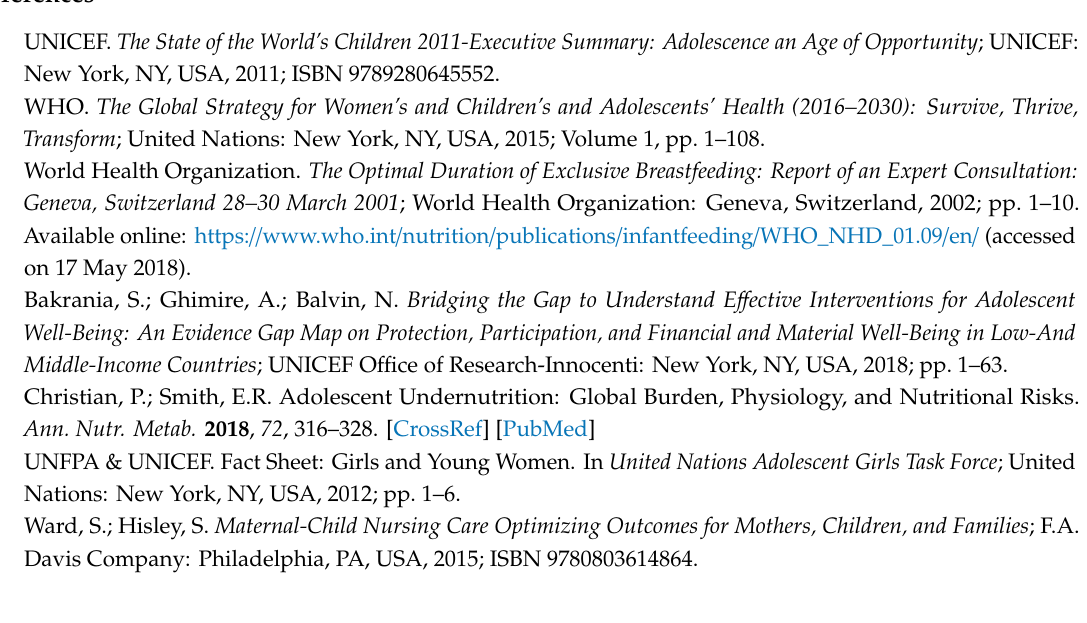
Table S1: Cochrane Collaboration Risk of Bias Tool scale item